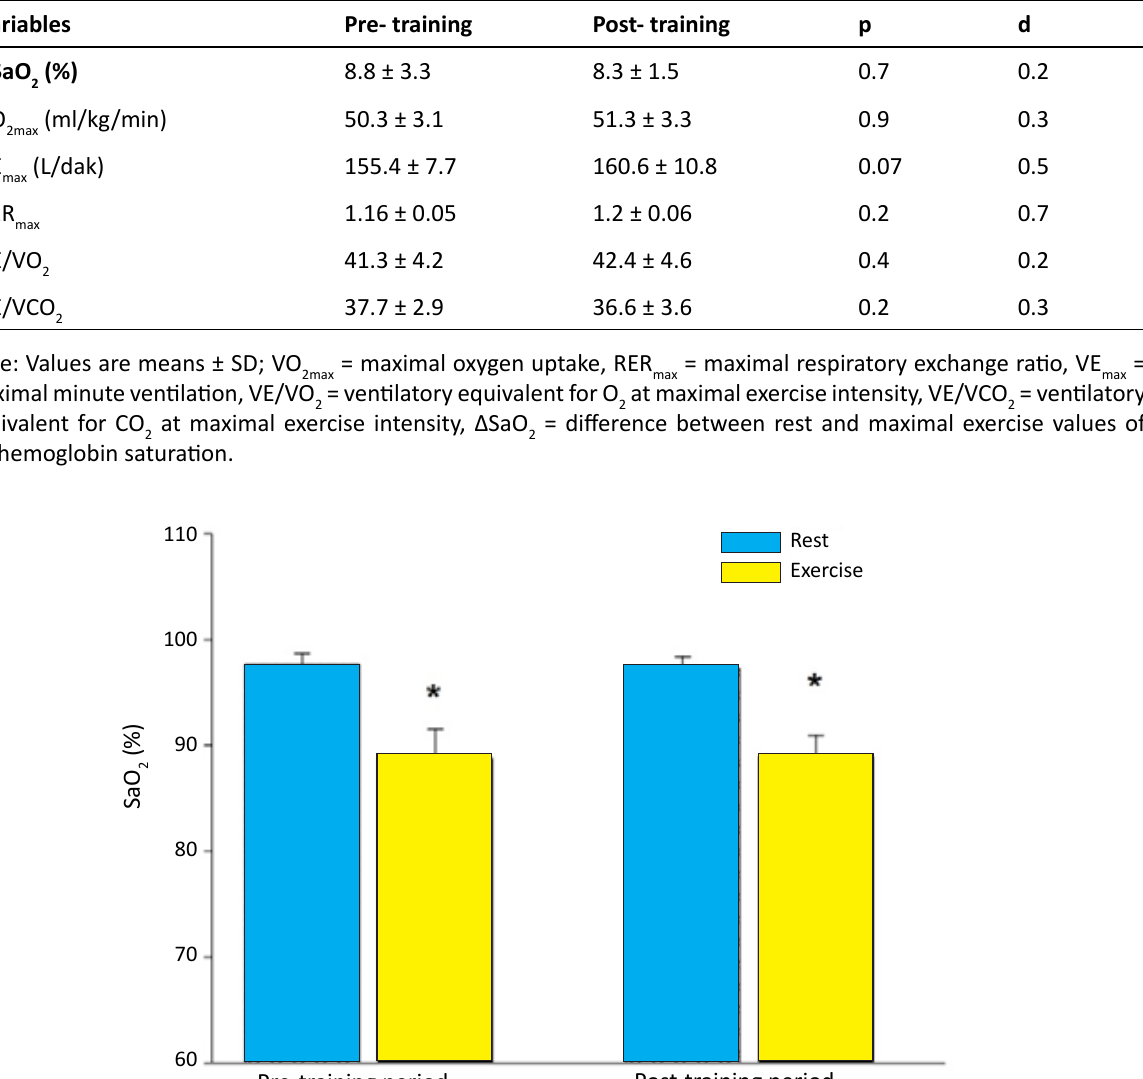
values at rest and maximum work rate during 2